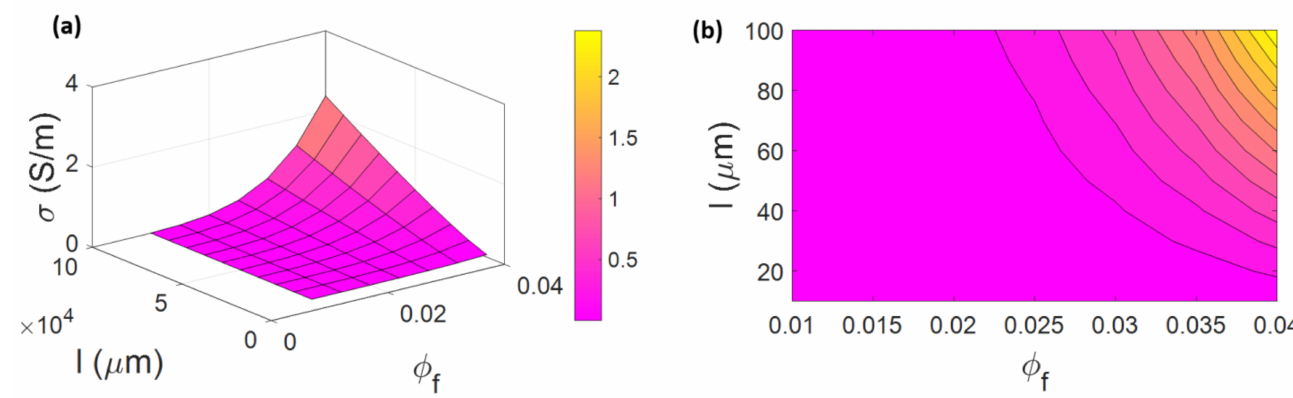
Figure 3. Impacts of “ ϕ f “ and “ l “ on the conductivity by ( a ) 3D and ( b ) 2D